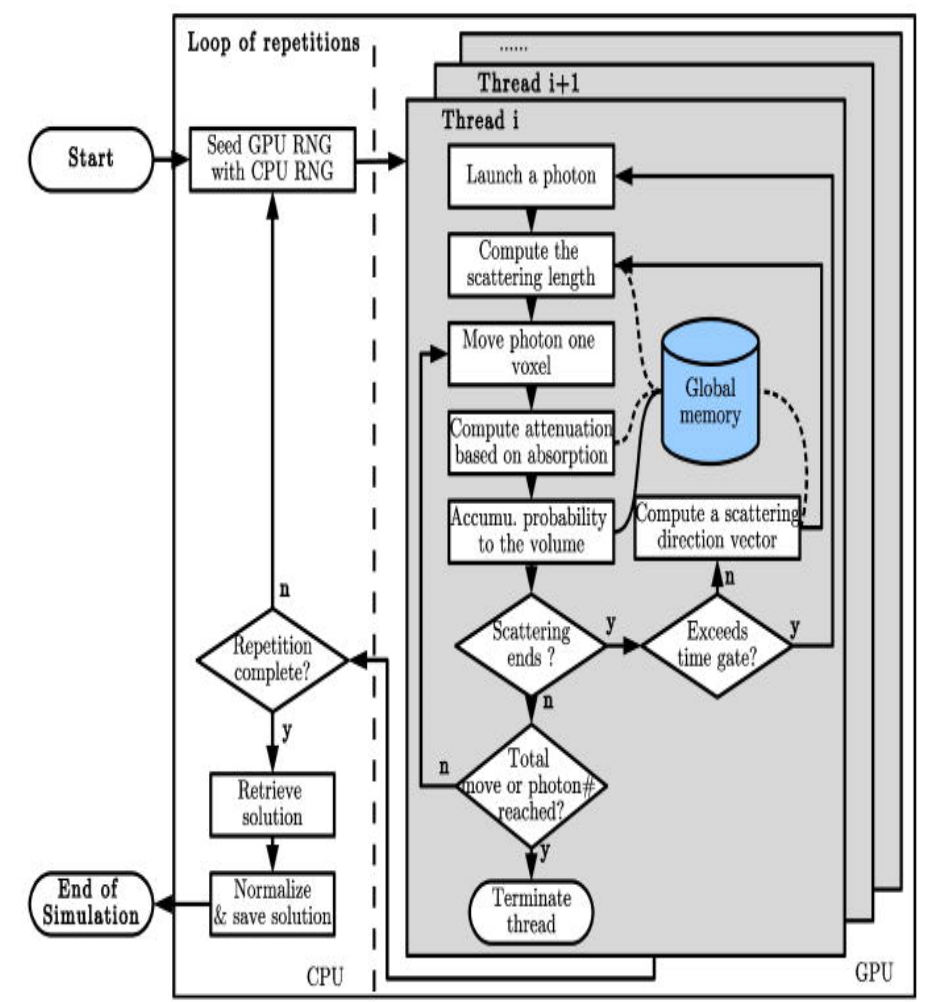
Figure 6. Basic steps of MCX technique (adapted from Ref. [56]).